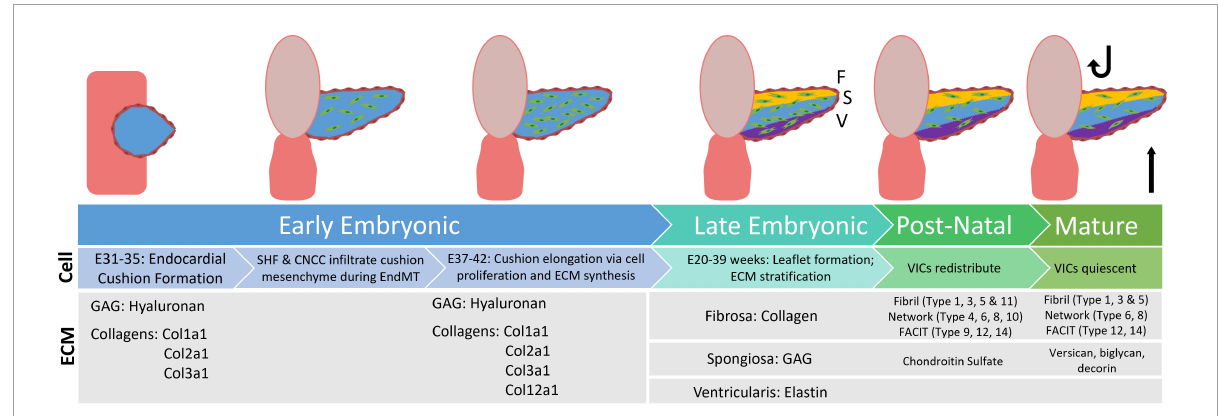
FIGURE1 Flowchart displaying distribution of extracellular matrix proteins during the stages of valve development, from early embryonic through the mature aortic valve. GAG, glycosaminoglyca; SHF, second heart field; CNCC, cardiac neural crest cells; EndMT, endothelial to mesenchymal transition; VIC, valvular interstitial cells [development information edited from Combs et al. (6). ECM information edited from Peacock et al. (4)].